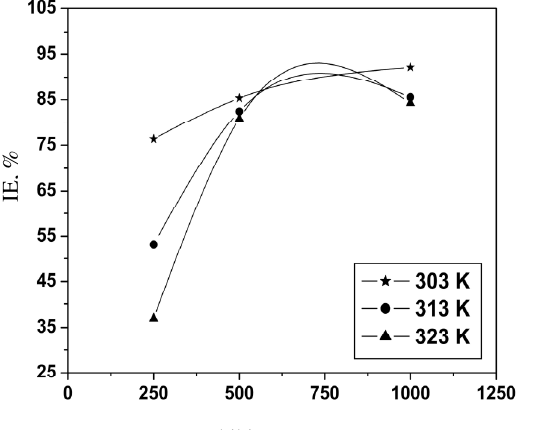
Figure 1. Variation of inhibition efficiency as a function of inhibitor concentration at different temperatures in 1 N H